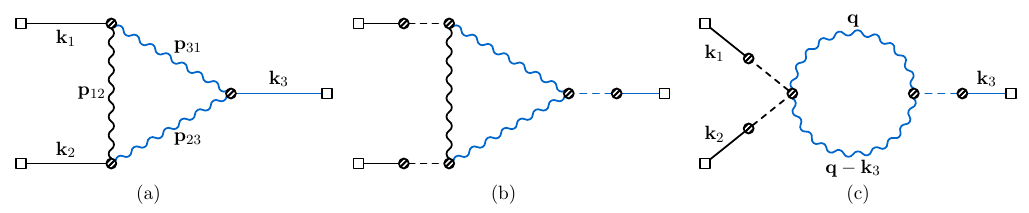
1 Figure 4 . One-loop diagrams contributing to gauge boson signals. The blue color marks the soft